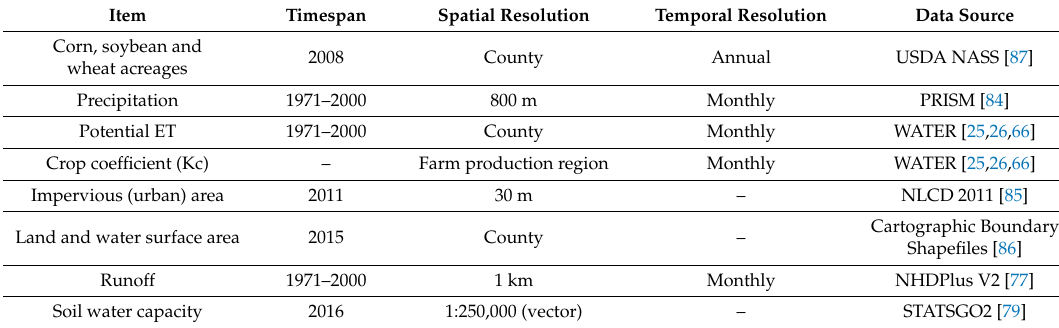
Table 2. Input data for green water and crop water demand